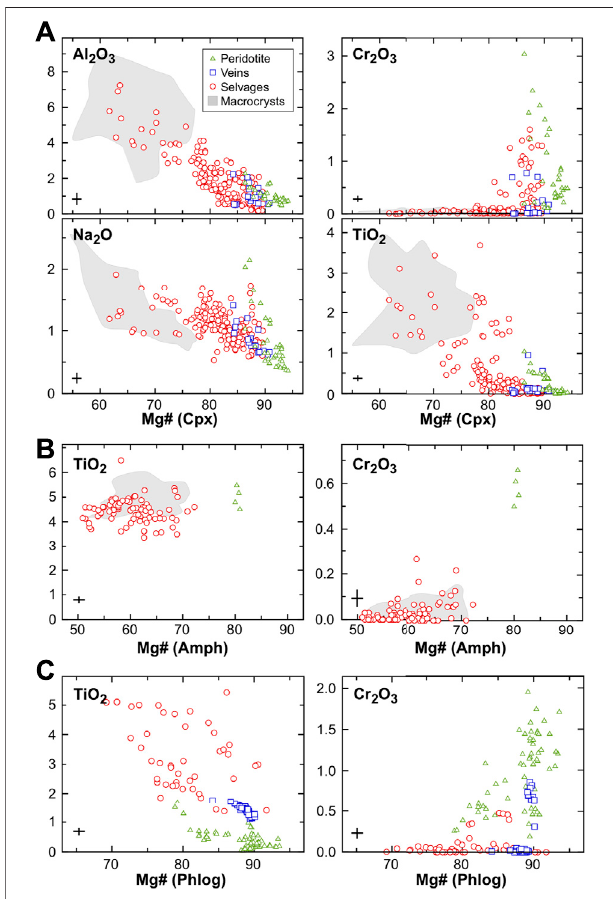
FIGURE7| Chemicalcompositionsof (A) clinopyroxene, (B) amphibole, and (C) phlogopite in peridotite xenoliths with their selvages and veins. Peridotite clinopyroxene refers to larger grains in samples with acumulate-like texture. Gray fi elds mark the range for clinopyroxene and amphibole macrocrysts in the host tephriphonolite. Error bars indicate analytical uncertainty (±1 standard deviation) as based on the analyses of secondary